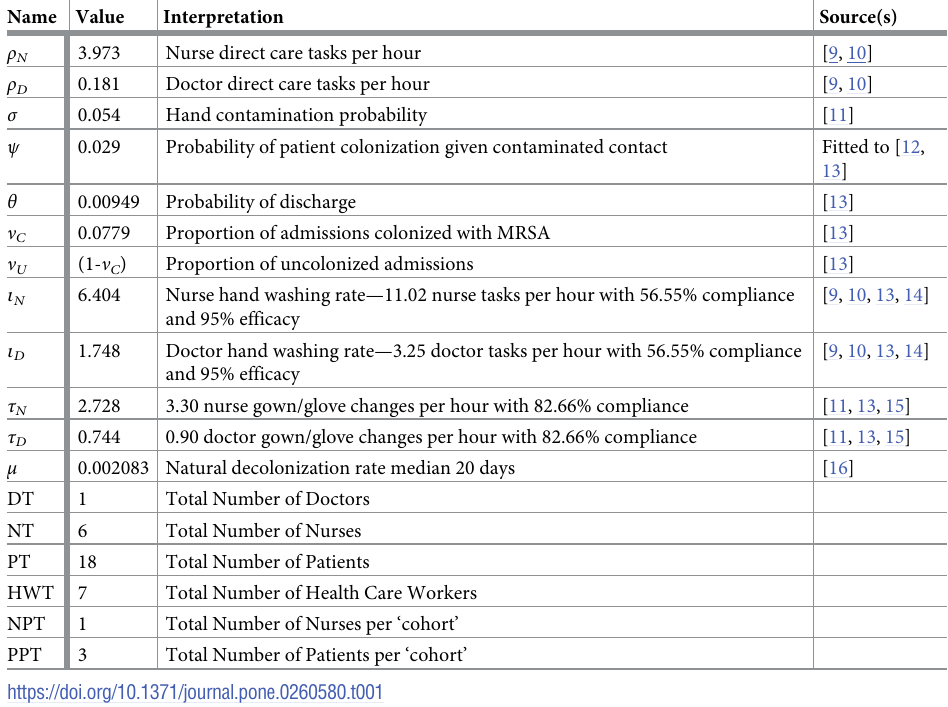
Table 1. Parameter values for models of MRSA transmission in an